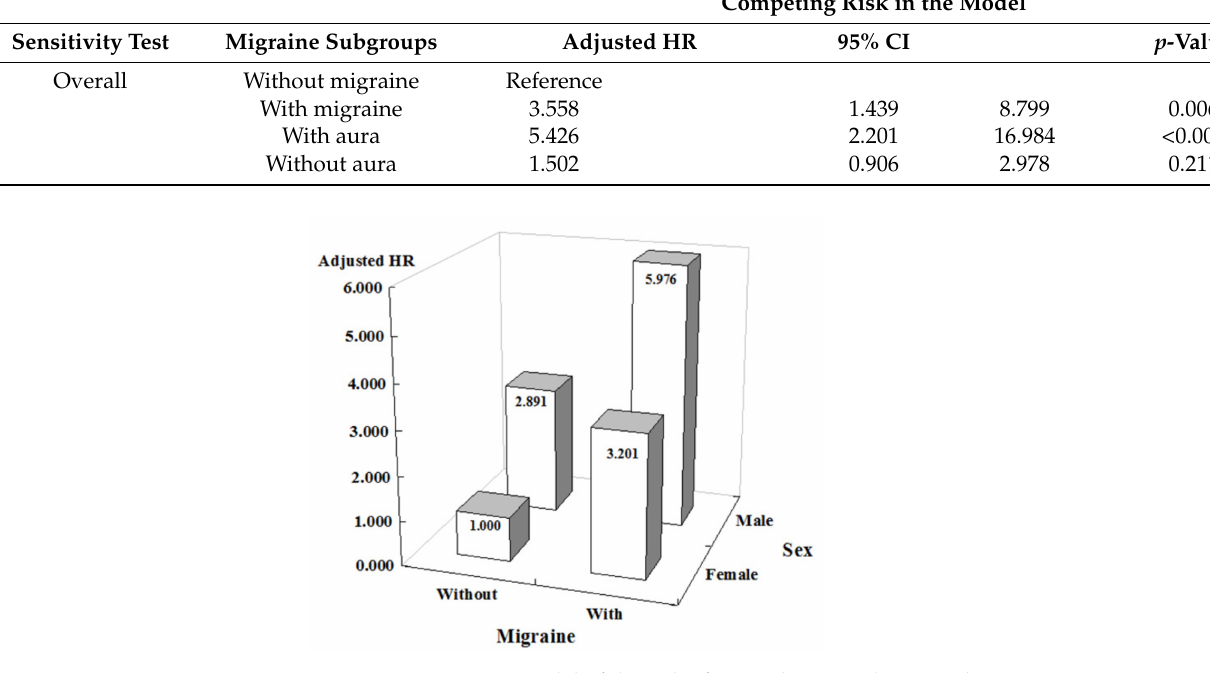
Figure 3. Interaction model of the risk of AAA due to male sex and